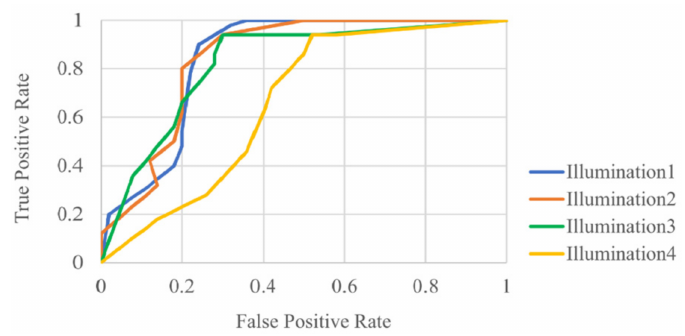
Figure 23. The ROC curve of GoogLeNet under different